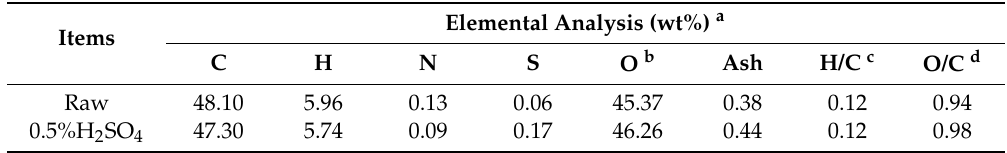
Table 4. Elemental analysis of raw and acid-impregnated eucalyptus.